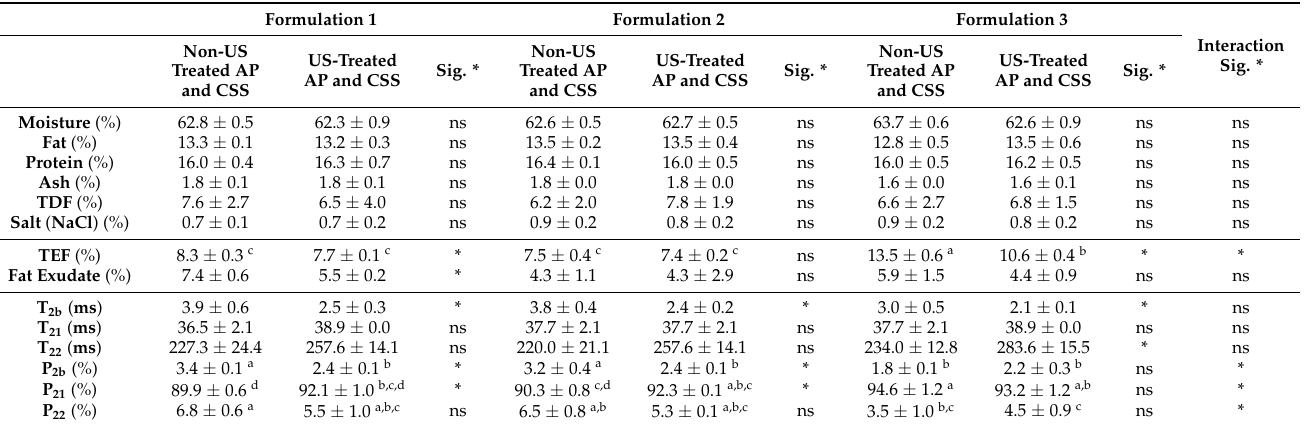
Table 1. Mean and standard deviation values of proximate compositions, emulsion stability, and NMR population distribution percentage of sausage formulations. (n =